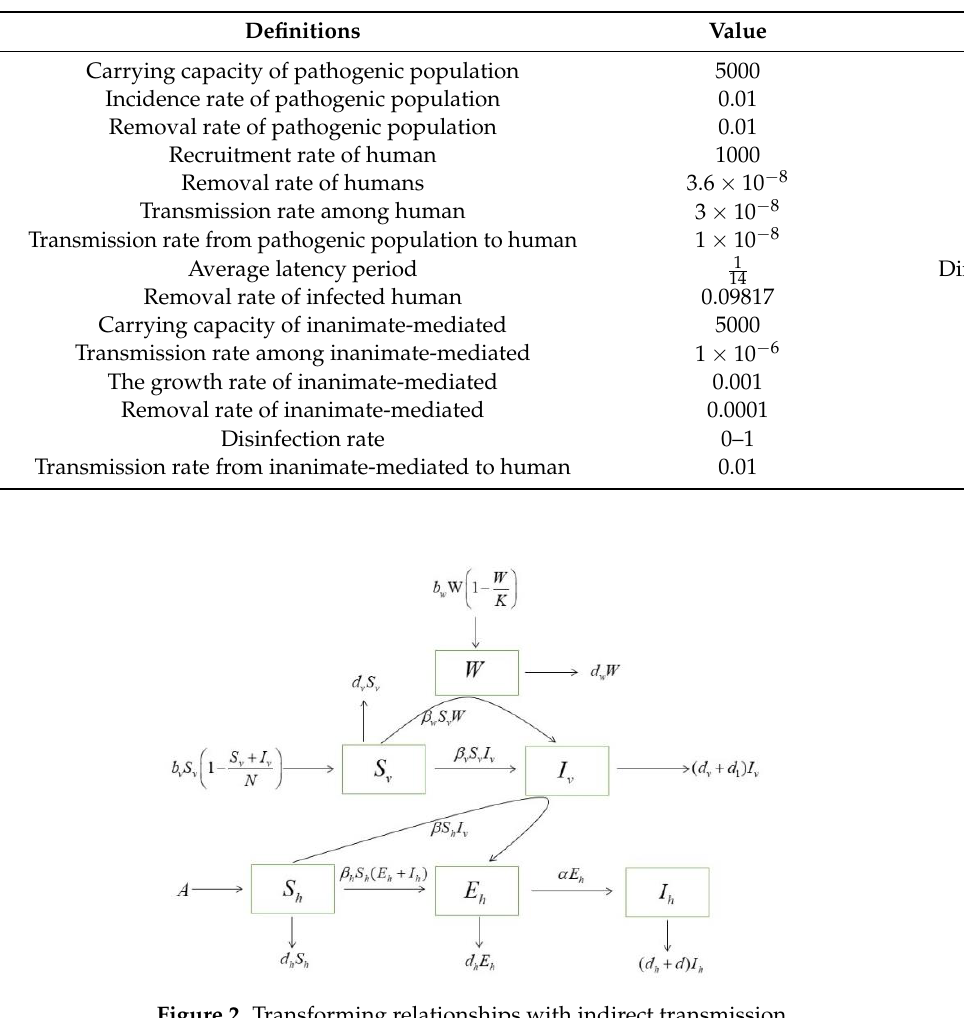
Figure 2. Transforming relationships with indirect transmission.